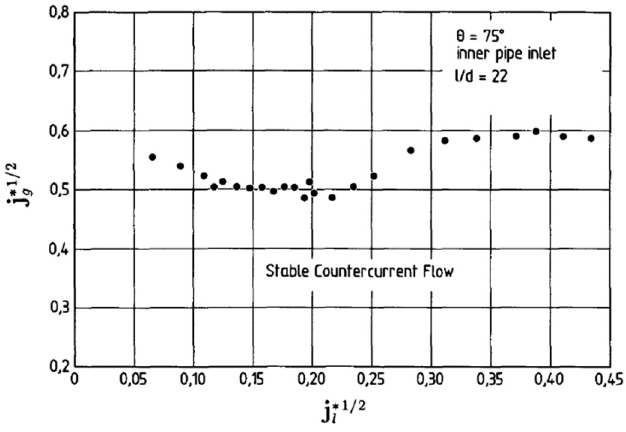
Figure 7. Typical flooding curve (Wongwises [75]).